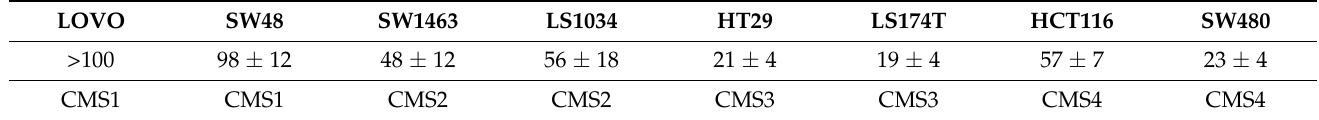
Figure 3. Impact of CAIX/CAXII expression on tumor biological functions of HT29 cells ( a ): im- munocytochemistry of monolayer culture showing ubiquitous expression of both CAIX (left) and CAXII (right) (scale bar: 100 µ m). ( b ): Western blot analyses of CAIX/CAXII expression in mock and knockdown cells. Two different shRNAs were used for each CA. ( c ): Spheroid forming from single- cell level was significantly reduced in cells with the combined CAIX/CAXII knockdown and mock cells treated with SLC-0111 (mean with SD, n ≥ 3). ( d ): Significant reduction in colony number in mock cells treated with SLC-0111 (mean with SD, n ≥ 3). ( e ): Significant reduction in colony size in mock cells treated with SLC-0111 (median with range, n ≥ 3). The clonogenicity assay and single- cell spheroid assay were repeated three or more times per condition in separate trials. (*: p ≤ 0.05, **: p ≤ 0.01.)